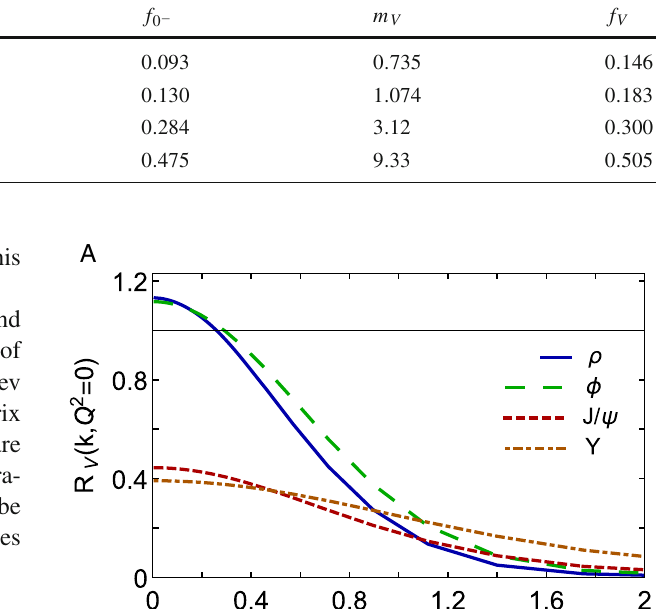
Table 2 Masses and decay constants obtained using the bound-state equations defined by Eqs. (18), (33): ˆ m is the renormalisation-group- invariant current-quark mass for the identified quark; 0 − labels ground- state pseudoscalar systems; and V , ground-state vector states. The 0 − state is a fictitious pseudoscalar meson computed as a benchmark in